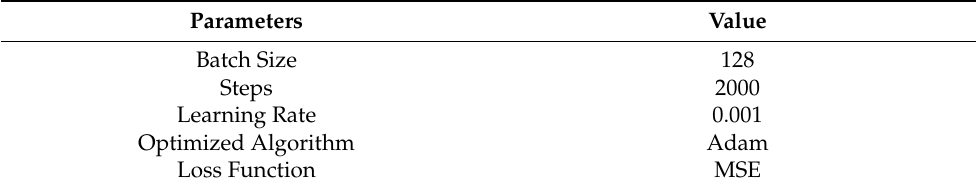
Table 1. The hyperparameters of the Autoptcr